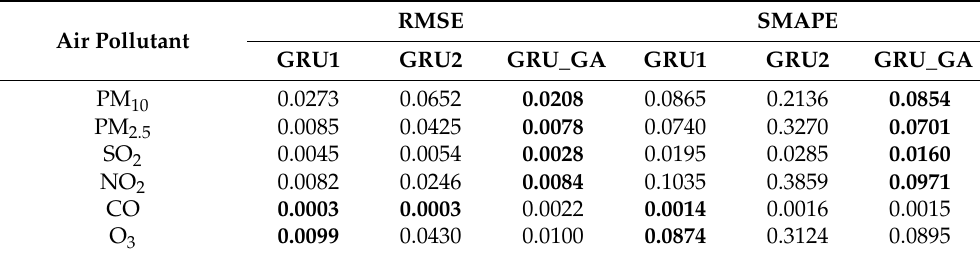
Table 12. The result of the adaptive GRU network structure compared with manually designed GRU network structures with Dataset 3.